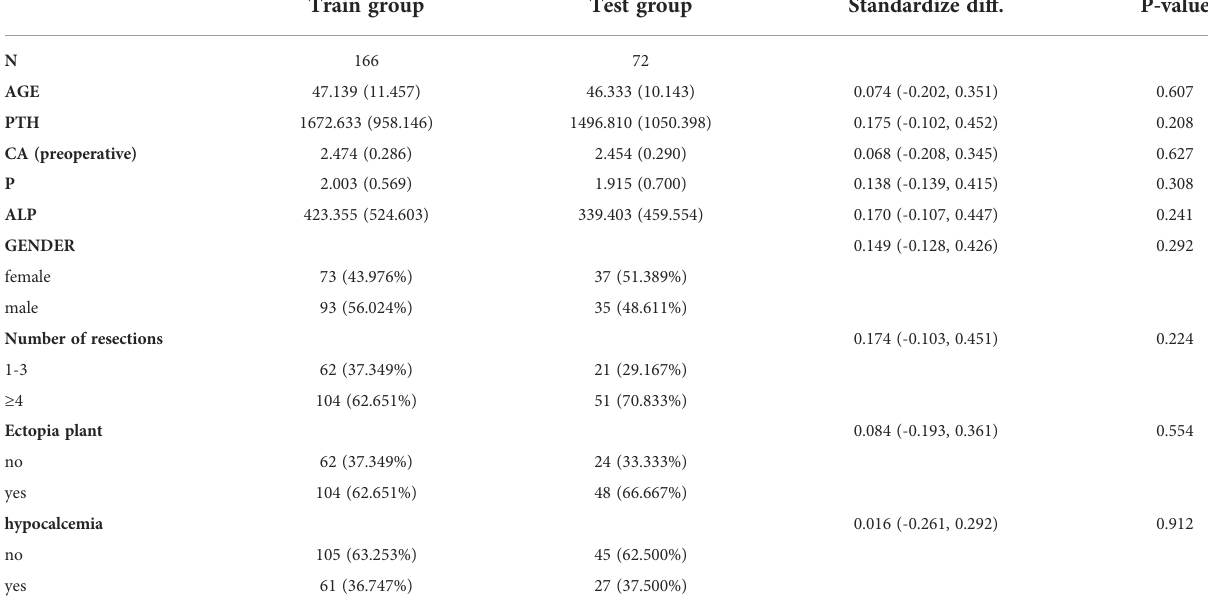
TABLE 1 Description of study population. Train group Test group Standardize diff.